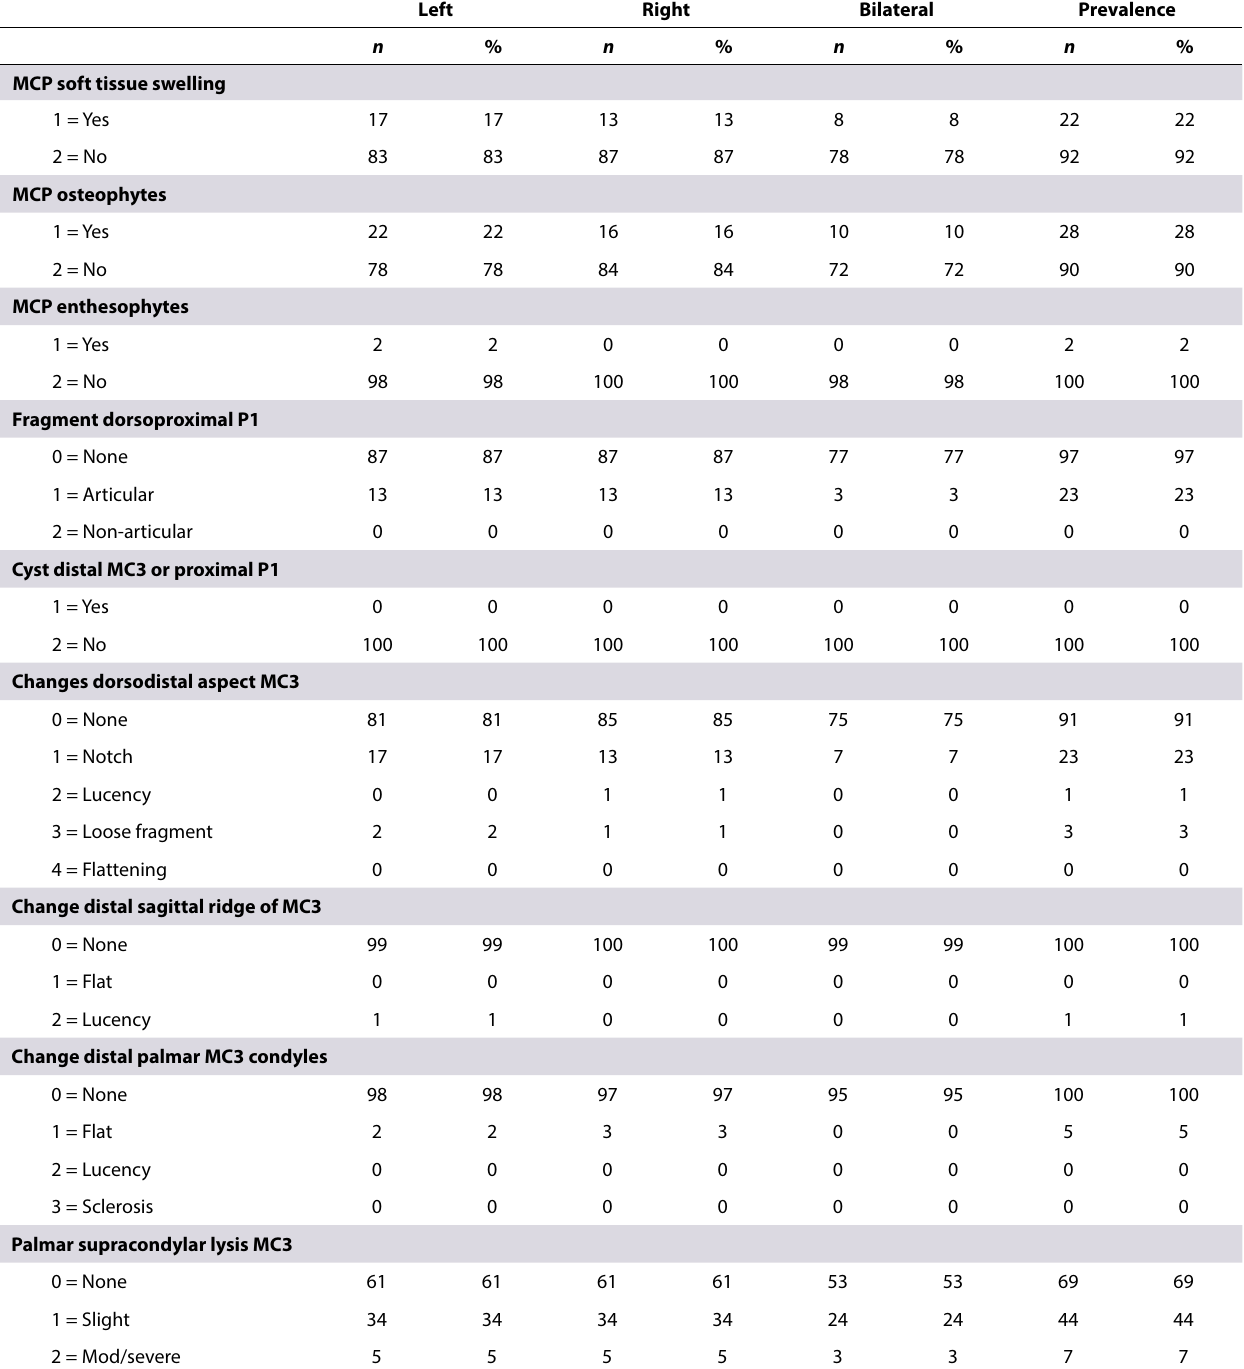
Table II: Radiographic changes in the metacarpophalangeal joints of endurance racehorses ( n = 100) Left Right Bilateral